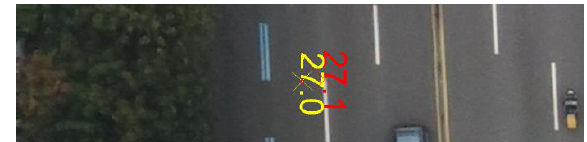
Figure 11. Vertical position comparison between adjacent models